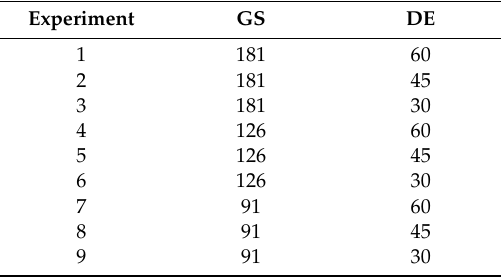
Table 1. Honing experiments performed.